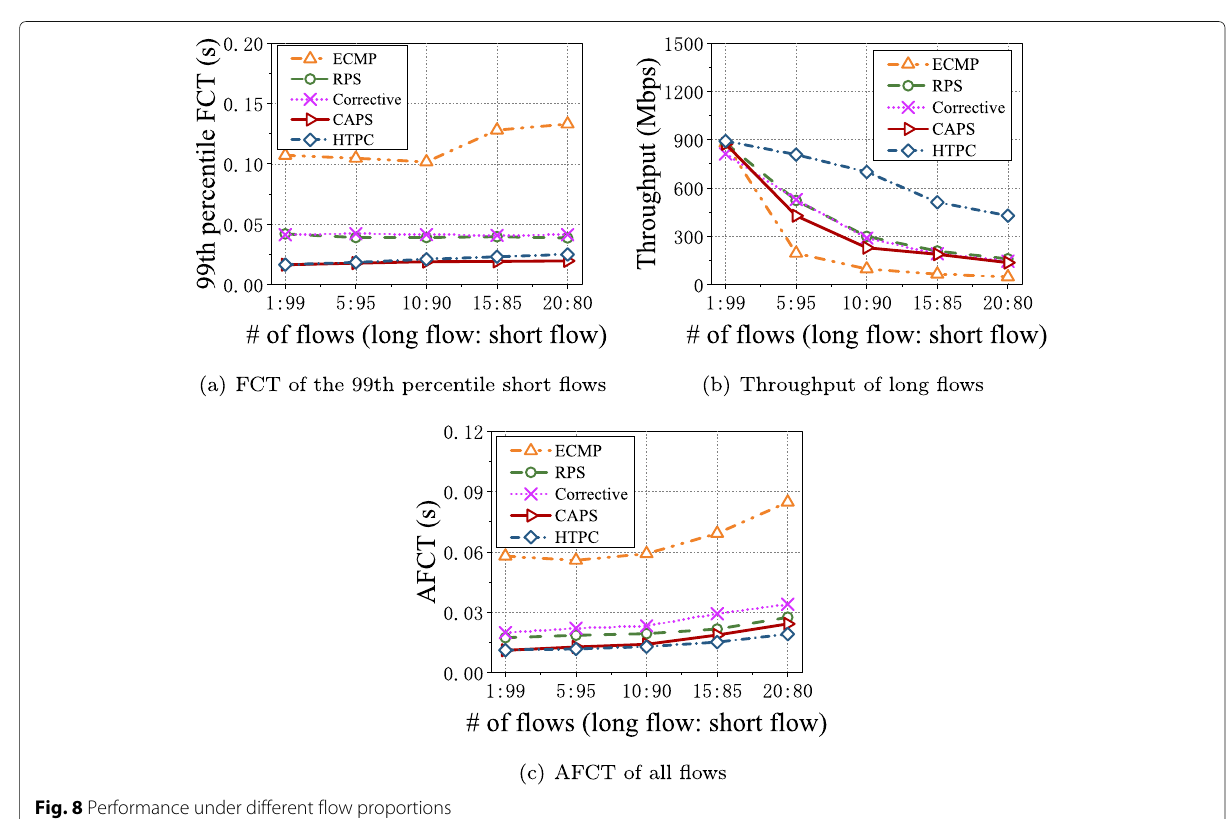
RPS do not distinguish between long and short flows, resulting in large queueing delay for short flows and tail- ing flow completion time. Corrective does not consider the real-time network status and transmits fixed num- ber of redundant encoded packets without distinguishing long and short flows so that the improved performance is